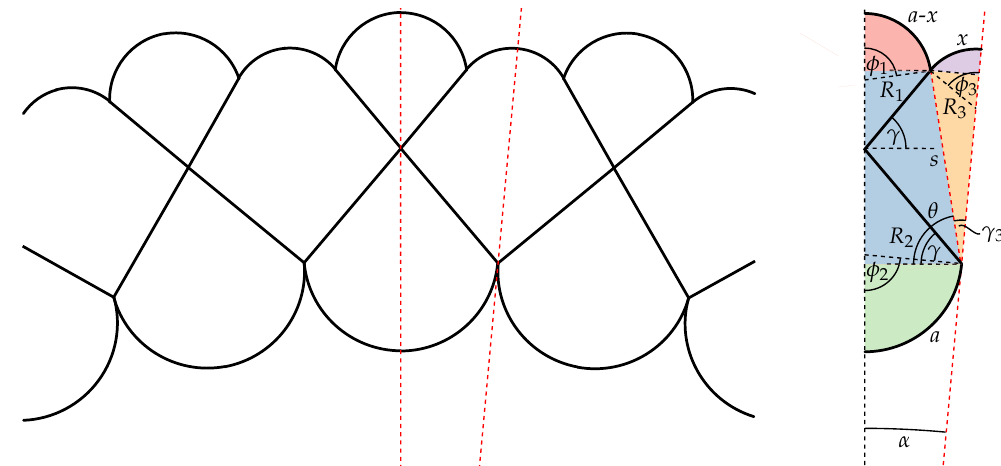
Figure 14. Curved woven mattress and geometric relations of an individual